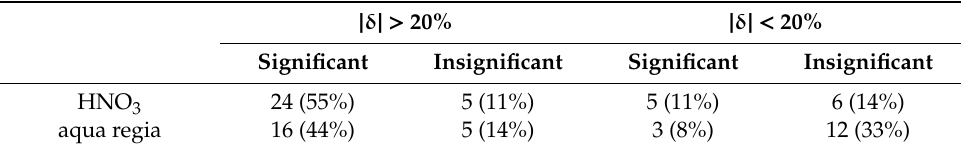
Table 4. Number of cases with significant di ff erences ( p < 0.02) between in-house and validated